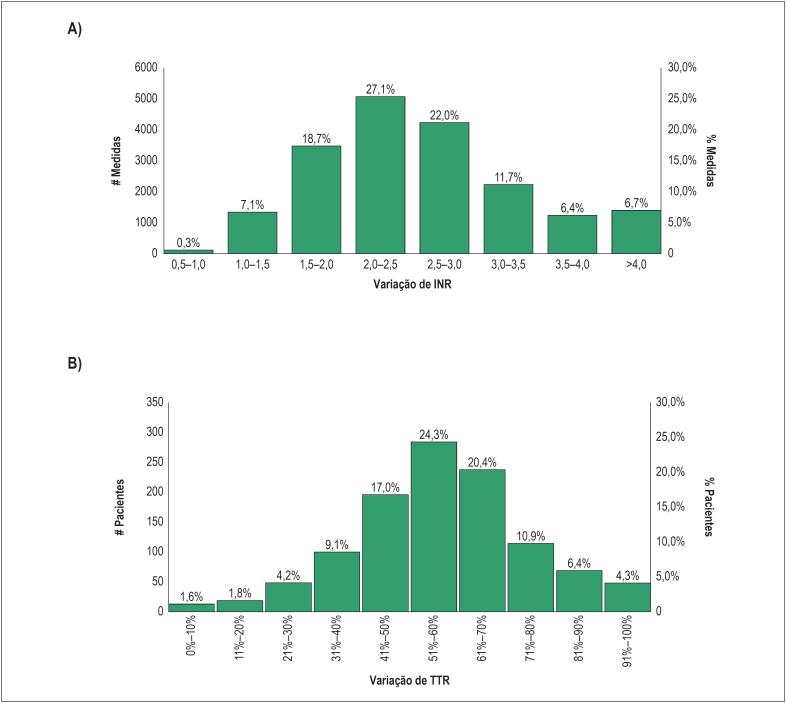
Resultados de INR e TTR. A. Distribuição das medidas por faixa de INR. B. Distribuição de pacientes por variação de TTR.